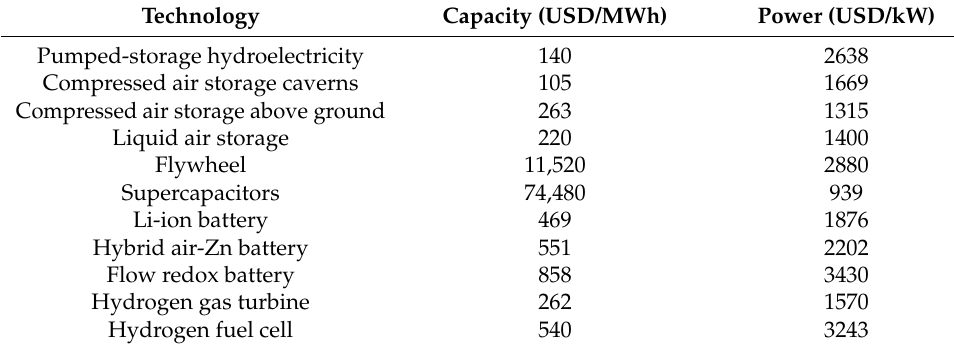
Table 1. Cost estimations for various energy systems [6,8–10]. Technology Capacity (USD/MWh) Power